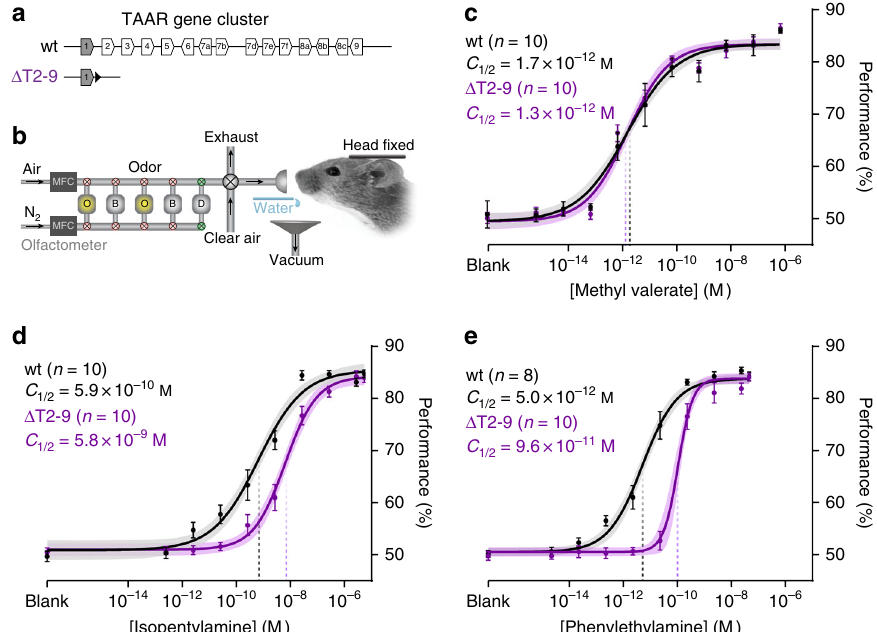
Fig. 1 Removing olfactory TAARs causes detection de fi cits to amines. a Diagram of the wild-type mouse TAAR gene cluster (wt) and cluster deletion ( Δ T2-9 ). Olfactory TAARs (white) and non-olfactory Taar1 (shaded) are shown (polygons re fl ect gene orientation). LoxP site indicated as black triangle. b Schematic of odor delivery for thresholding in head- fi xed mice. Flow dilution olfactometer switches between a pressure-balanced dummy (D) carrier vial (via normally open valves, green) and either odor (O) or blank (B) vials (via normally closed valves, red). During stimulus application, a fi nal valve re- directs pressure-balanced, odorized air from exhaust to the animal. Mice lick for water reward in Go/No-Go detection task. c – e Psychometric curves of wild-type (black) and mice lacking all olfactory TAARs (purple) to two amines (isopentylamine and phenylethylamine) and one non-amine (methyl valerate). Plots show mean + / − SE with a shaded 95% con fi dence interval. Data were fi tted with a Hill function. Behavioral sensitivity is de fi ned as the odor concentration at half-maximal behavioral performance ( C ½ ) during a head- fi xed Go/No-Go conditioned assay. Methyl valerate: wt C ½ = 1.7 × 10 − 12 M (95% CI = 0.9 – 3.5 × 10 − 12 M); Δ T2-9 C ½ = 1.3 × 10 − 12 M (95% CI = 0.7 – 2.2 × 10 − 12 M). Isopentylamine: wt C ½ = 5.9 × 10 − 10 M (95% CI = 3.0 – 11.2 × 10 − 10 M); Δ T2-9 C ½ = 5.8 × 10 − 9 M (95% CI = 3.7 – 9.0 × 10 − 9 M). Phenylethylamine: wt C ½ = 5.0 × 10 − 12 M (95% CI = 3.2 – 7.6 × 10 − 12 M); Δ T2-9 C ½ = 9.6 × 10 − 11 M (95% CI = 6.2 – 12.1 × 10 − 11